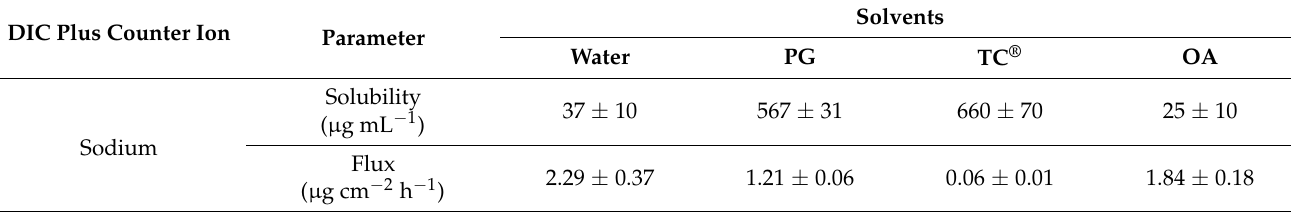
Table 10. Impact of different solvents on the solubility and flux of DIC in conjunction with different salts as counter ions. According to the authors, saturated solutions of the DIC salts were applied for permeation experiments ( n = 3, values represent the mean ± S.D.) Adapted with permission from [38], Elsevier,